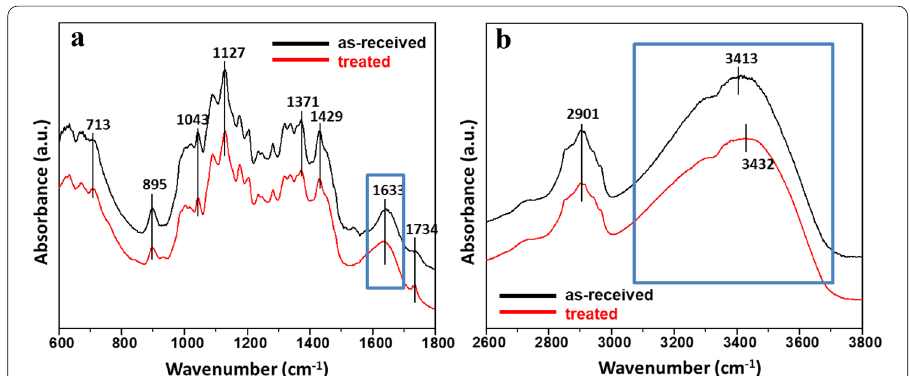
Fig. 4 FTIR Spectra of as‑received and thermochemically treated muslin sample ( a ) 600–1800 cm − 1 regions